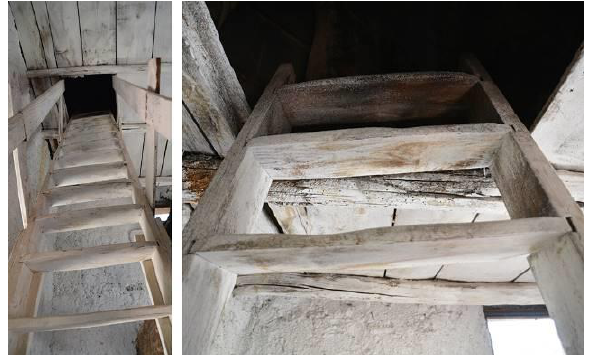
Figure 5. Stair in the bell cell of San Giovanni in Bronte (Ct).